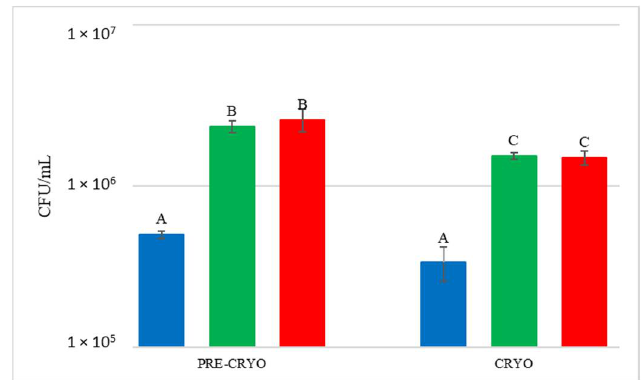
Figure 6. Total yeast count before (PRE-CRYO) and after (CRYO) cryomaceration. NT: untreated control (blue), LCC: low cell concentration (green), HCC: high cell concentration (red). Data are expressed as the average of three replicates ± standard deviations. Different letters indicate significant differences between values ( p = 0.05).